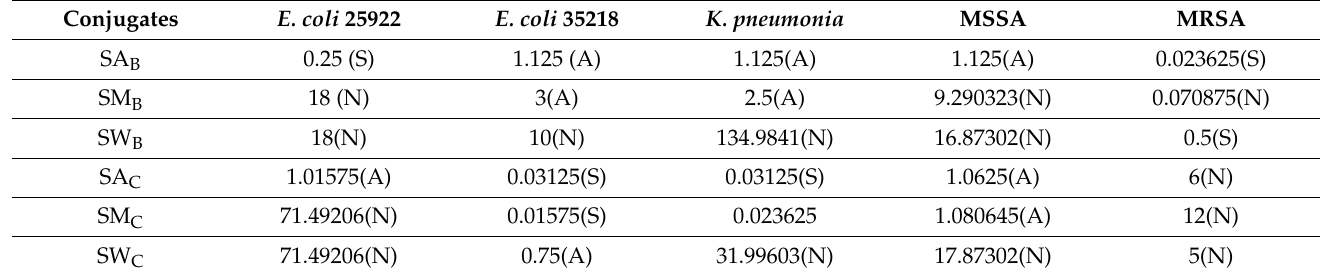
Table 3. Effect of conjugating P. grandiflora tuber extracts with silver nanoparticles.